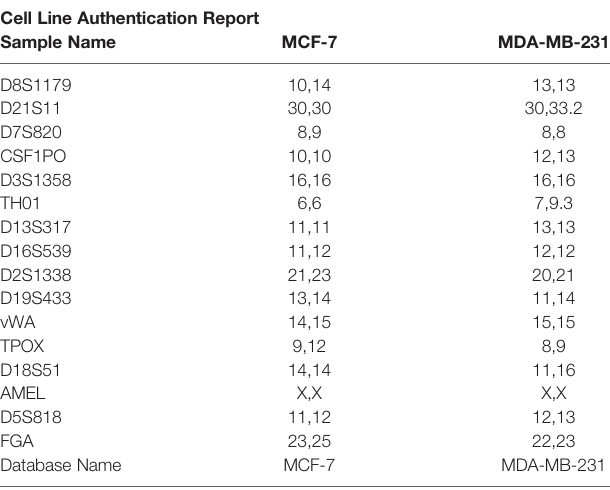
TABLE 1 | Cell Line Authentication. The table shows the result of the cell line analysis. Cell Line Authentication Report Sample Name